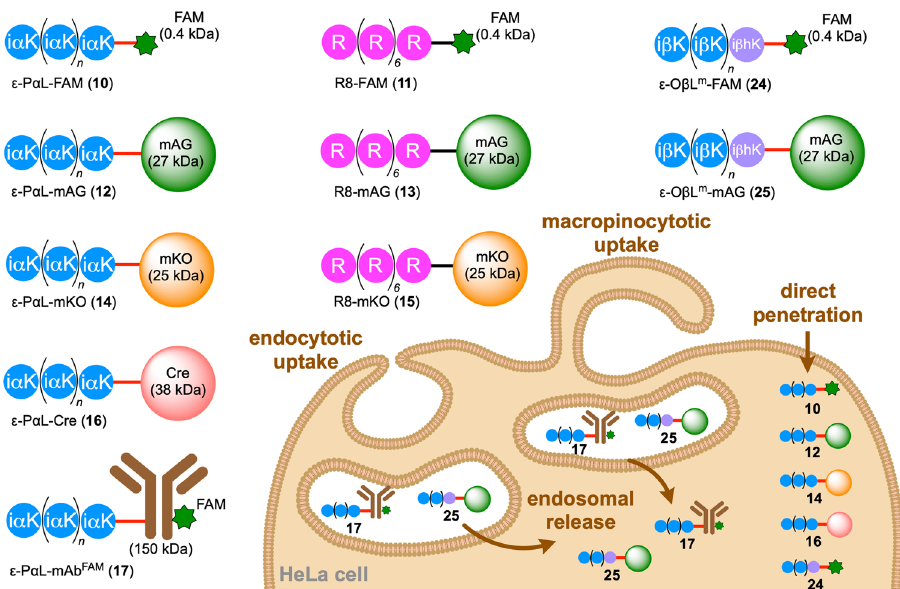
Fig. 2 Schematic diagrams of cargoes conjugated with polycationic peptides. A fl uorescein dye (FAM) and proteins (mAG, mKO, and mAb) were conjugated with ε -P α L, R8, or ε -O β L m by click chemistry, and the resulting products are schematically shown. Their chemical structures validated by HPLC- HR-ESI-MS data are shown in the Supplementary Tables. Our present study demonstrated the dominant pathways for their intracellular uptake (bottom right). Compounds 10 , 12 , 14 , 16 , and 24 were internalized into cells mainly by direct penetration. However, 17 and 25 were taken up into cells by endocytosis and/or macropinocytosis and were then released from endosomes. Compounds 11 , 13 , and 15 were used as canonical CPP